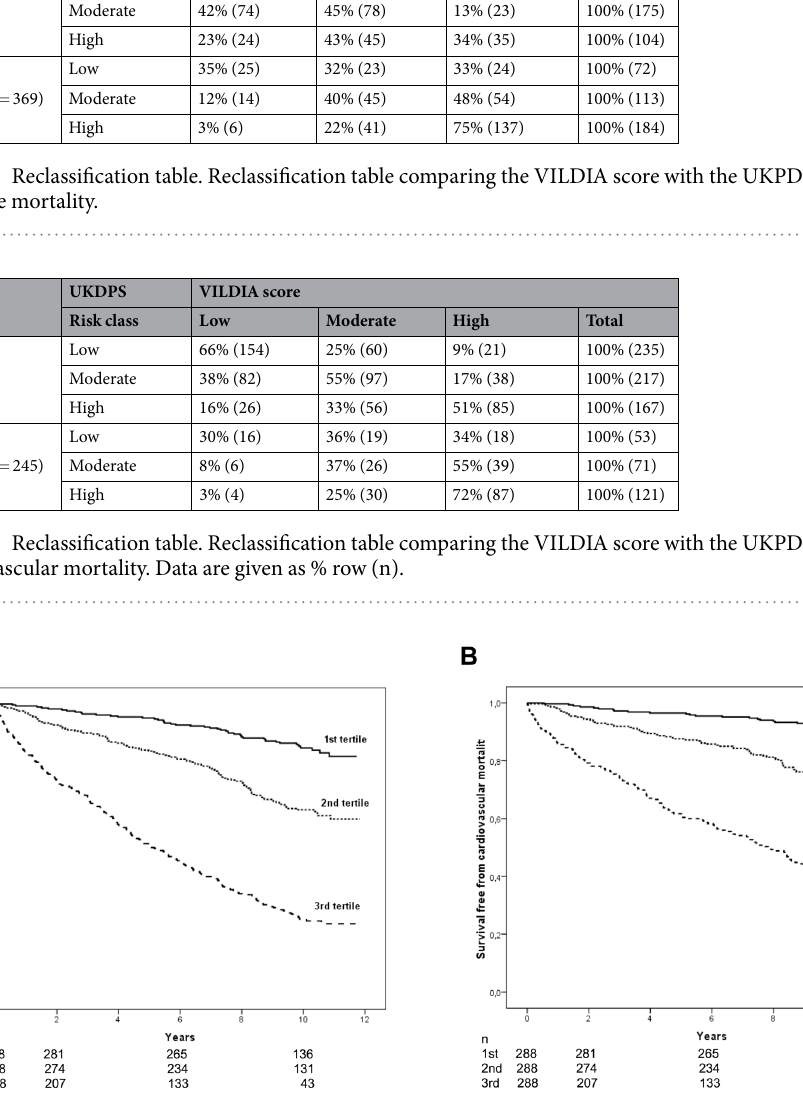
Figure 2. Kaplan-Meier estimates of mortality. Kaplan-Meier estimates for tertiles of VILDIA score for all- cause mortality ( A ) and cardiovascular mortality ( B ) (all P < 0.001 between all tertiles, log rank